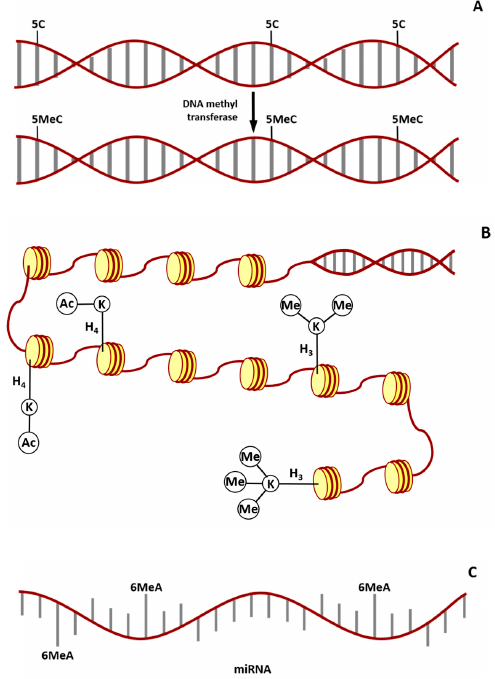
Figure 3. Chromium epigenetic effects on (A) DNA, (B) histones and (C) miRNAs. ( A ) The methylation of DNA in the presence of DNA methyltransferase involves the bond of a methyl group to the cytosine forming 5-methylcytosine. ( B ) The H3 and H4 histone tails undergo covalent reactions that include methylation and acetylation. The acetylation of the N -terminal lysine residue is a process regulated by histone lysine acetyltransferases. Histones are also methylated on lysine thanks to histone lysine methyltransferases. ( C ) MicroRNAs are subjected to a covalent methylation modification coordinated by methyltransferases.